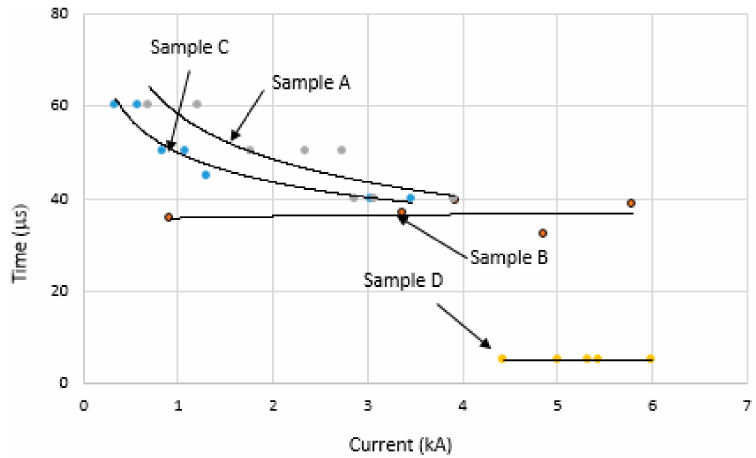
Figure 12. Time to discharge to zero for current against peak current for 4-rod electrodes installed at sites 1, 2, 3 and 4 under positive polarity.